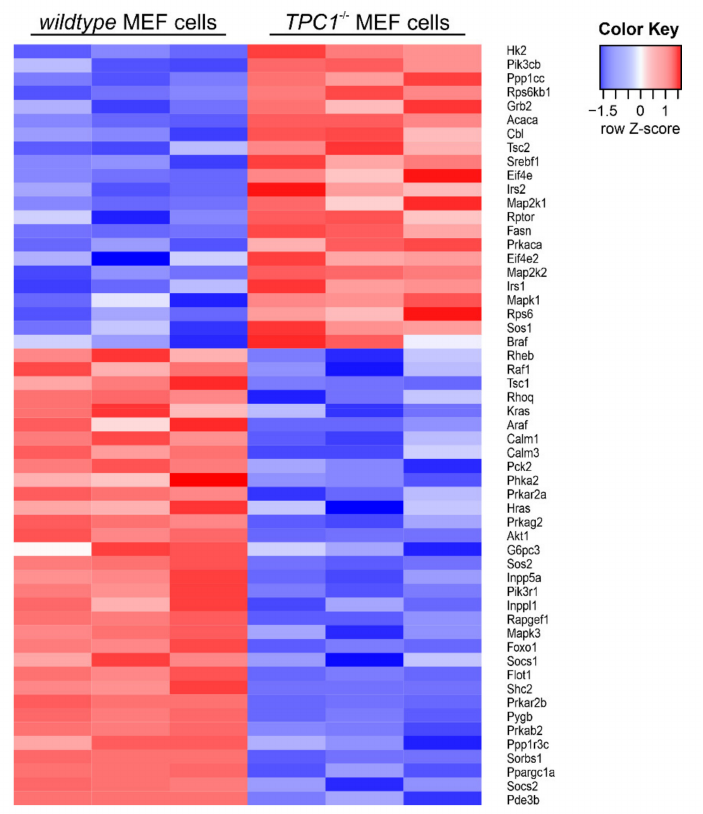
Figure 4. Heatmap of genes involved in insulin receptor signaling. Heatmap showing significantly differentially expressed genes (q < 0.05) in three independent samples ( n = 3) of TPC1 deficient MEF vs. wildtype cells that are involved in insulin receptor signaling (KEGG pathway 04910; [49]. Each column stands for one independent sample of the depicted genotype. Expression values are shown as the Z-scores of the log2 transformed normalized counts for each gene. Red and blue are assigned to higher and lower expression, respectively, according to the color key in the upper right. Heatmap was created using tools integrated in the Galaxy platform [46]. Original sequencing data were deposited in the Short Read Archive at the National Center for Biotechnology Information (NCBI) under the BioProject ID